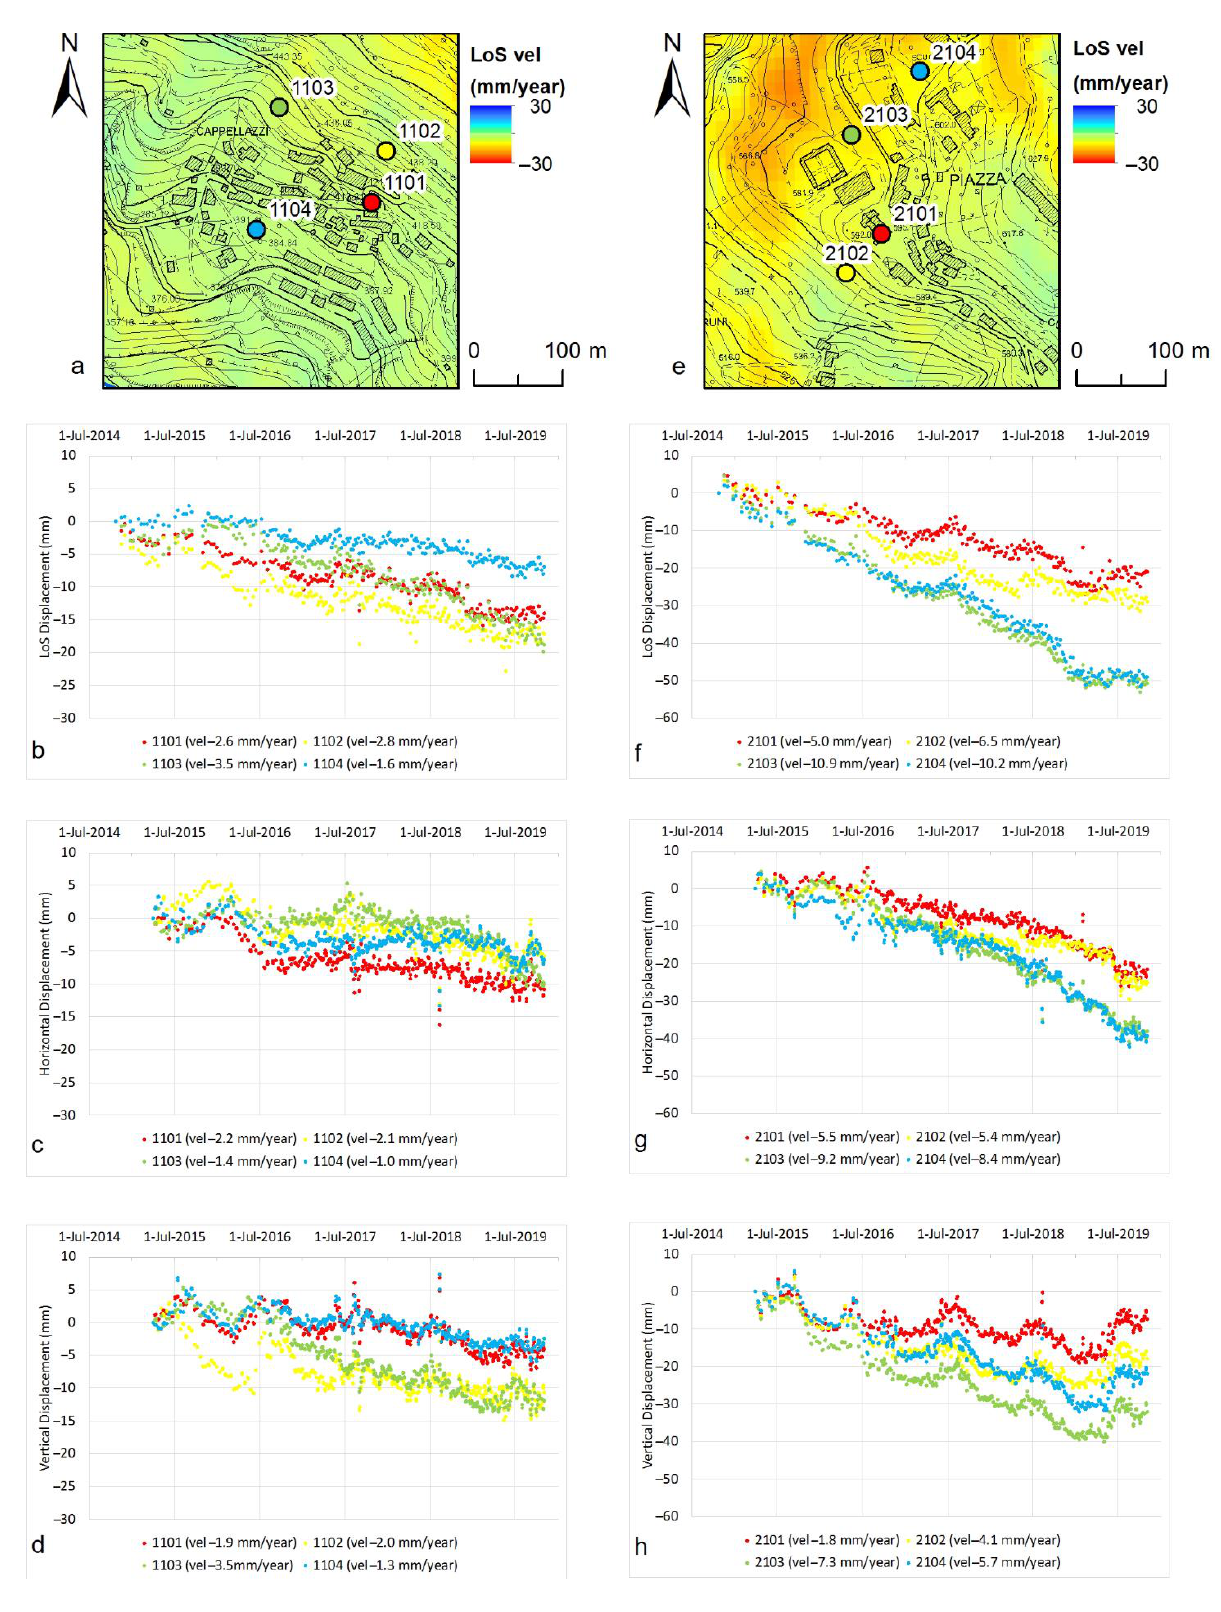
Figure 7. Descending LoS, horizontal and vertical displacement time series of points located at Cappellazzi district ( b – d ) and Rovegliana Church and its surrounding area ( f – h ). In ( a ) and ( e ) the location of points is shown on the descending LoS velocity maps. Points 1101 and 2101 are located at the damaged building in Cappellazzi and at Rovegliana Church, respectively (Figure